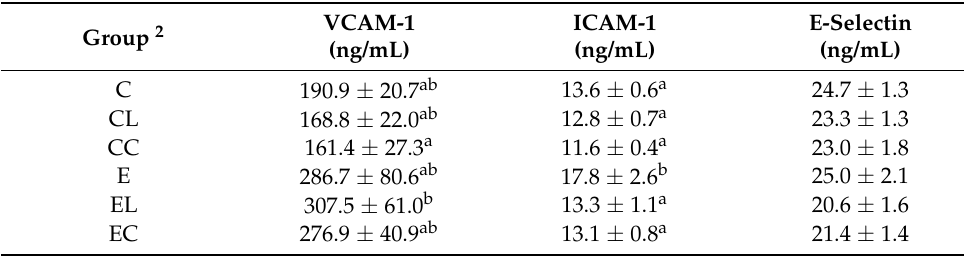
Table 9. Effects of different dietary fat sources on plasma vascular cell adhesion molecule (VCAM)- 1, intercellular adhesion molecule (ICAM)-1, and E-selectin levels in rats 1 .